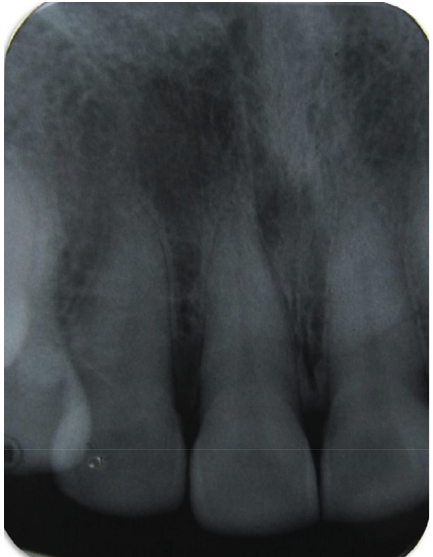
Figure 2: Intraoral periapical radiograph showing mild alteration in the trabecular pattern in relation to 11 and 12.